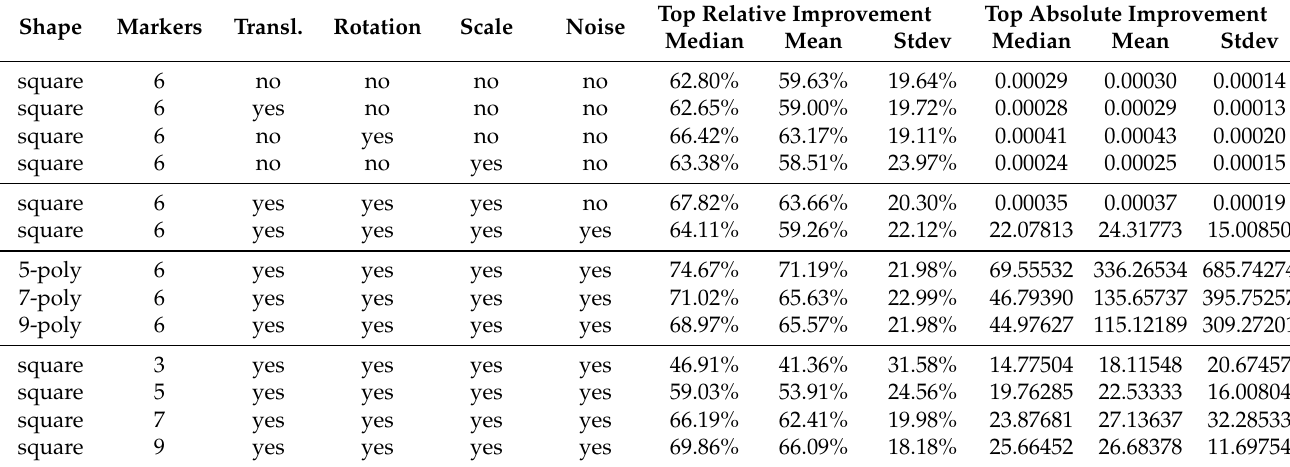
Table 1. Description of the test scenarios in our synthetic dataset with corresponding settings and results for the top-ranked homography. One row represents one test scenario. Four visually separated groups (from top to bottom) are related to experiments shown in Figures